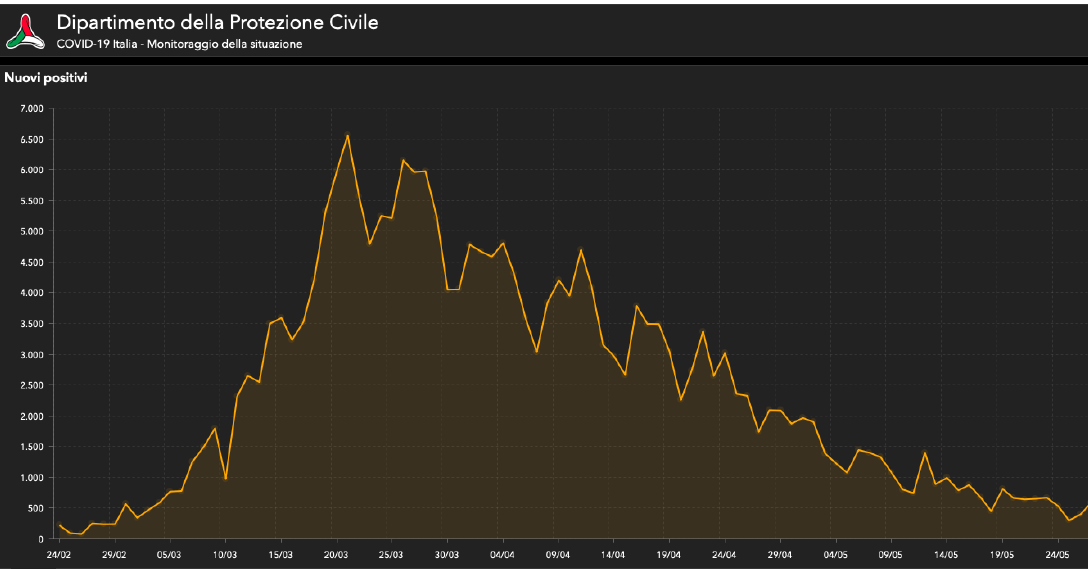
Figure 2. Graph showing the number of infections per day between February and May 2020 and highlighting the peak of infections between 20 and 30 March 2020. Official source: Ministero della Salute (Italian Ministry of Health). Last access: 28 May 2020. http://www.salute.gov.it/portale/nuovocoronavirus/dettaglioContenutiNuovoCoronavirus.jsp?lingua=italiano&id=5351&area=nuovoCoronavirus&menu=vuoto [17].